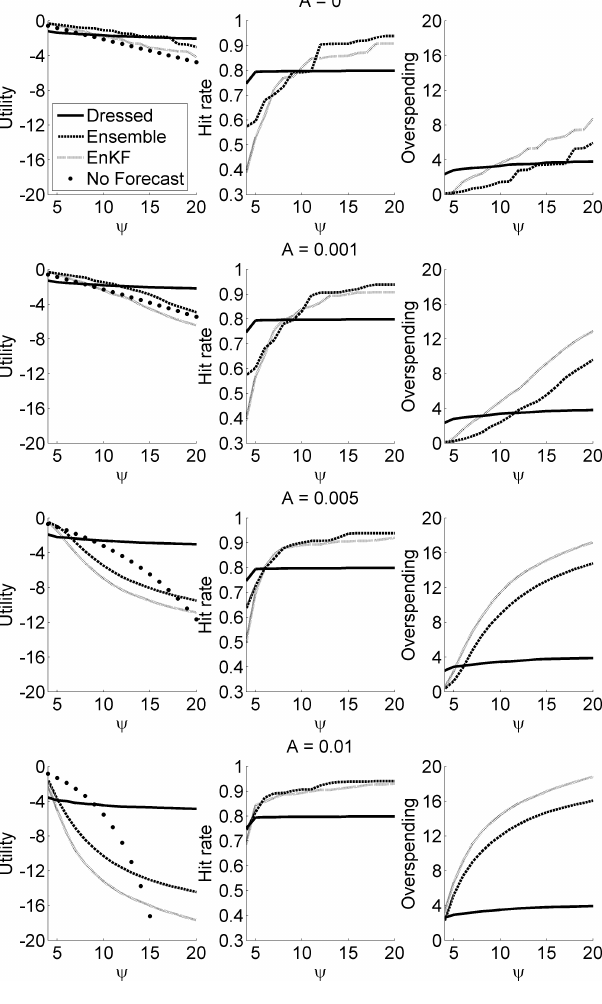
Figure 10. Utility, hit rate and overspending as a function of pa- rameter ψ for the three flood forecasting systems for various levels of risk aversion by the decision maker, when the decision maker is allowed to spend an increasing fraction of the total available money as the lead time